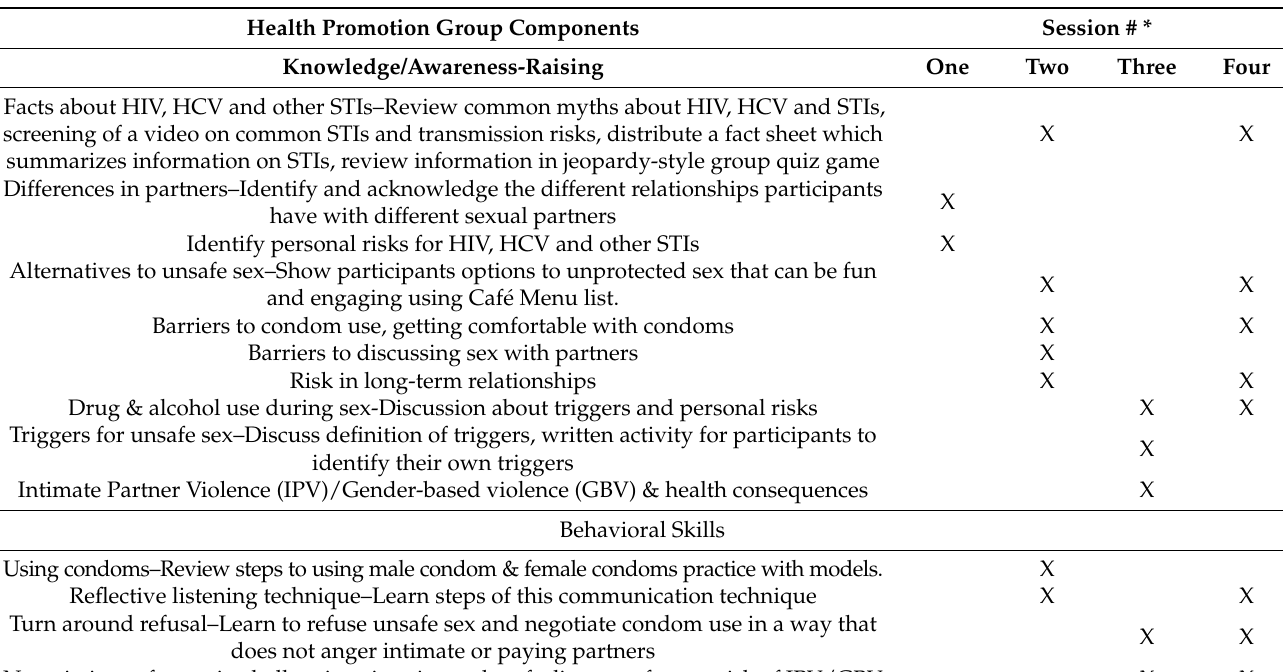
Table 1. Health promotion components integrated into HIVRR sessions.